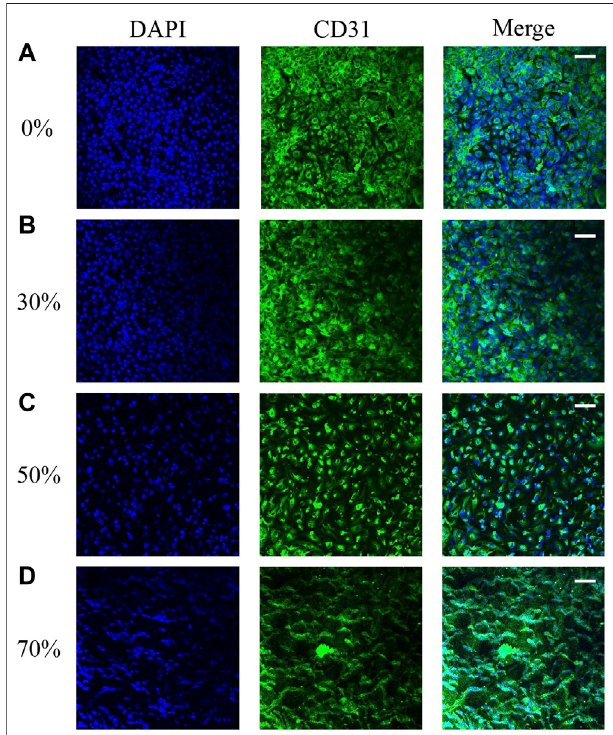
FIGURE 6 | EC morphology in 0 (A) , 30 (B) , 50 (C) , and 70% (D) stenosed structures under fl ow